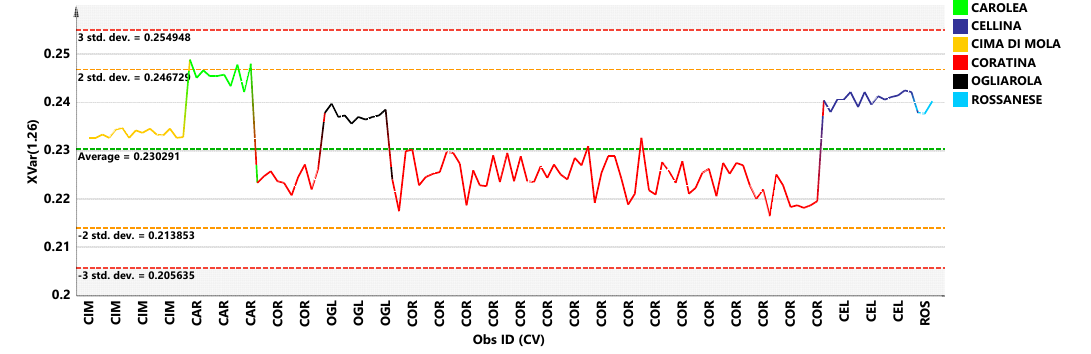
Figure 2. Variable trend plot with control limits of selected discriminating X variable (1.26 ppm). (CIM: Cima di Mola, Car: Carolea; Ogl: Ogliarola; COR: Coratina; CEL: Cellina di Nardò, ROS: Rossanese).